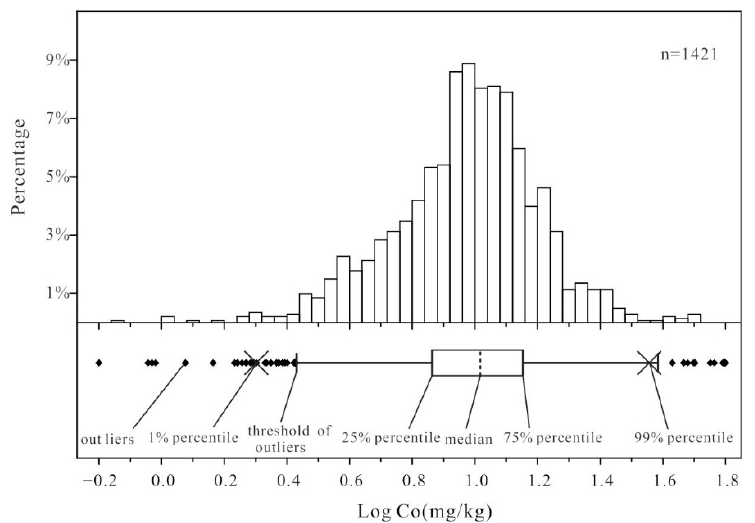
Figure 4. Histogram and boxplot displaying cobalt distribution in different grids throughout China. Notation: Outliers are cases with values larger than 1.5 times the box length (interquartile range) from the lower or upper edge of the box.